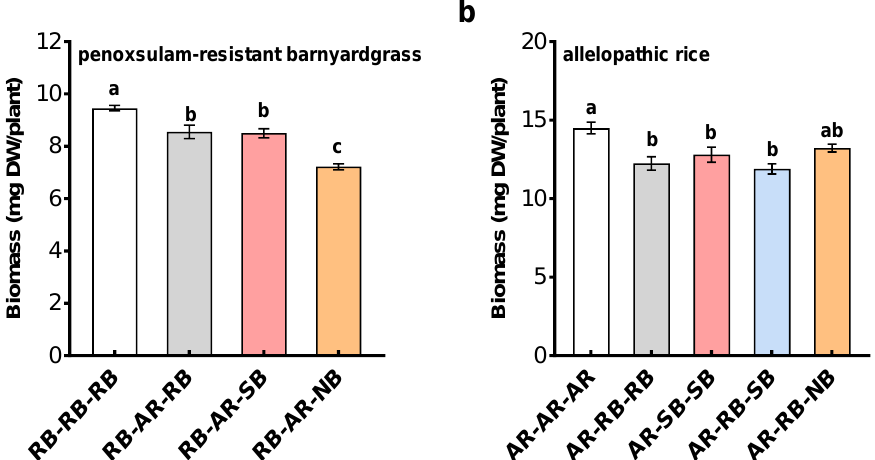
Figure 6. Effects of relatedness-mediated rice–barnyardgrass allelopathic interactions on biomass of penoxsulam-resistant barnyardgrass biotype ( a ) and allelopathic rice cultivar ( b ). RB , penoxsulam-resistant barnyardgrass biotype; SB, penoxsulam-susceptible barnyardgrass biotype; NB , normal barnyardgrass biotype; AR , allelopathic rice cultivar. Values plotted are means plus/minus SE. Columns with the same letter are not significantly different at p < 0.05 according to ANOVA, followed by Tukey HSD tests.